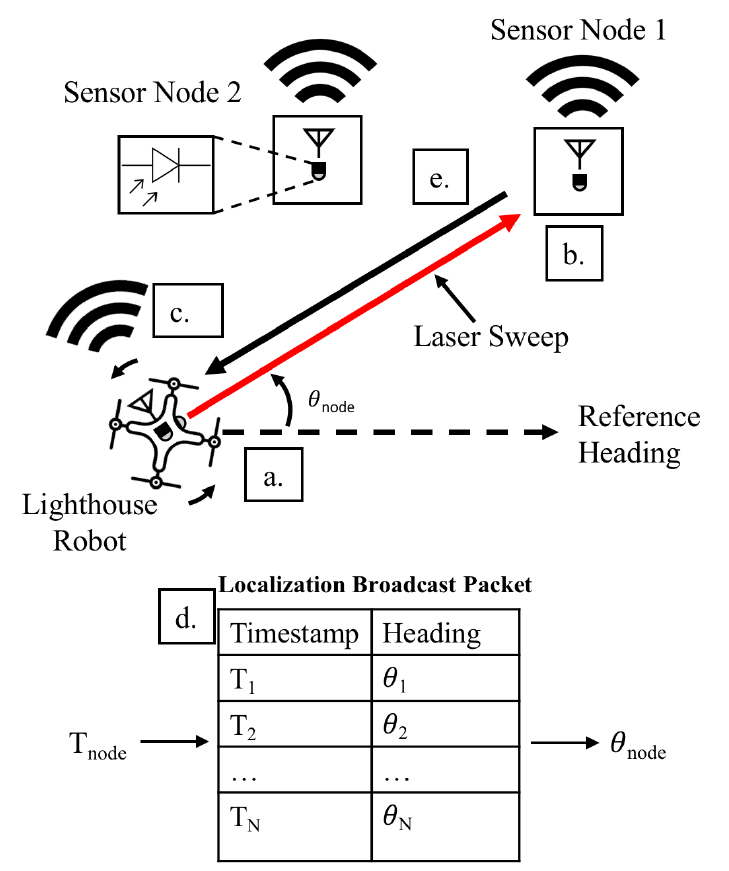
Figure 2. ( a ) The lighthouse quadrotor, with a mounted vertical planar laser, rotates while recording the heading-timestamp information from its attitude estimator. ( b ) Anchor sensor node 1 detects a laser sweep using its photodetector and records the network-synchronized timestamp of the laser detection event at T node . ( c ) The lighthouse robot periodically broadcasts its timestamp-orientation mapping to anchor sensor nodes. ( d ) Anchor sensor node 1 uses the received timestamp-orientation broadcast and T node to calculate its bearing θ node relative to the quadrotor. ( e ) Anchor sensor node 1 sends the relative bearing back to the lighthouse quadrotor, which the quadrotor uses to localize itself.